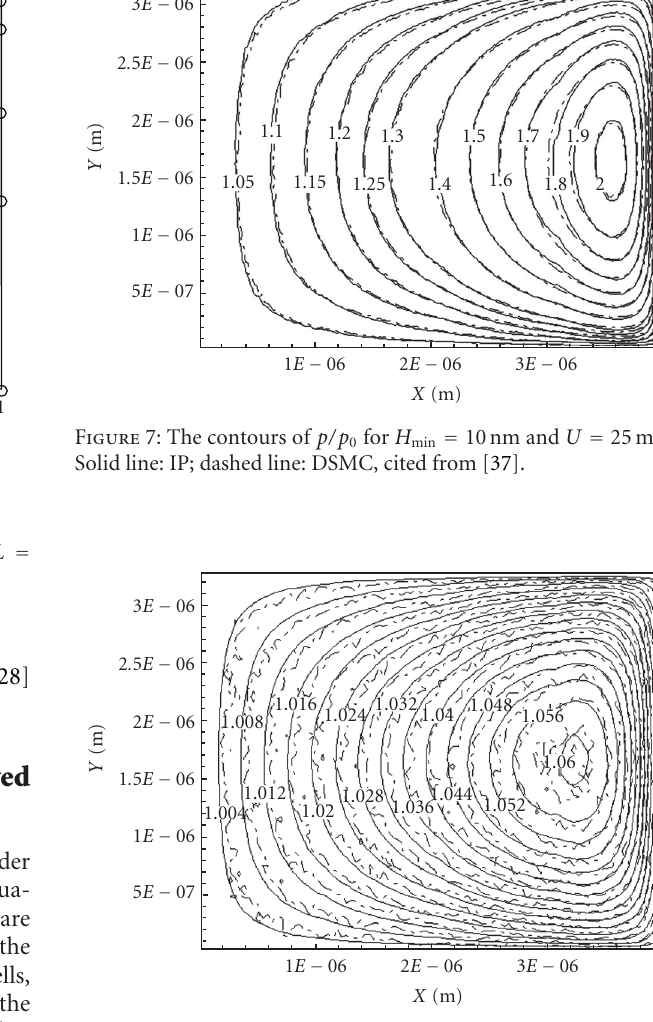
Figure 8: The contours of p/p 0 for H min = 10nm and U = 2m / s. Solid line: IP; dashed line: DSMC, cited from